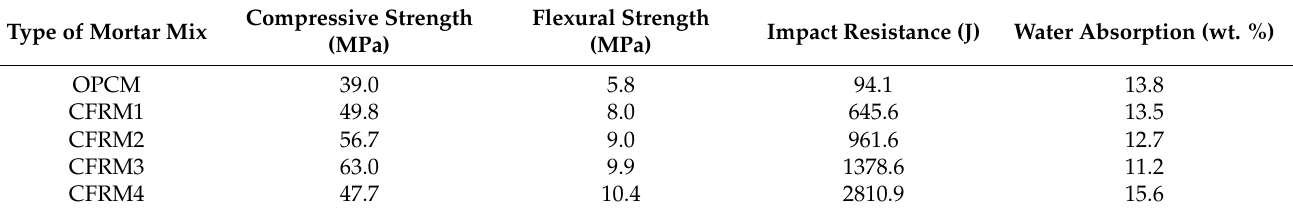
Table 4. Properties of the different hardened mortar